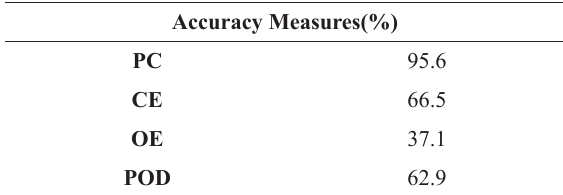
Standard accuracy measures computed from contingency Table I: Proportion Correct (PC), Commission Error (CE), Omission Error (OE) and Probability of Detection (POD).